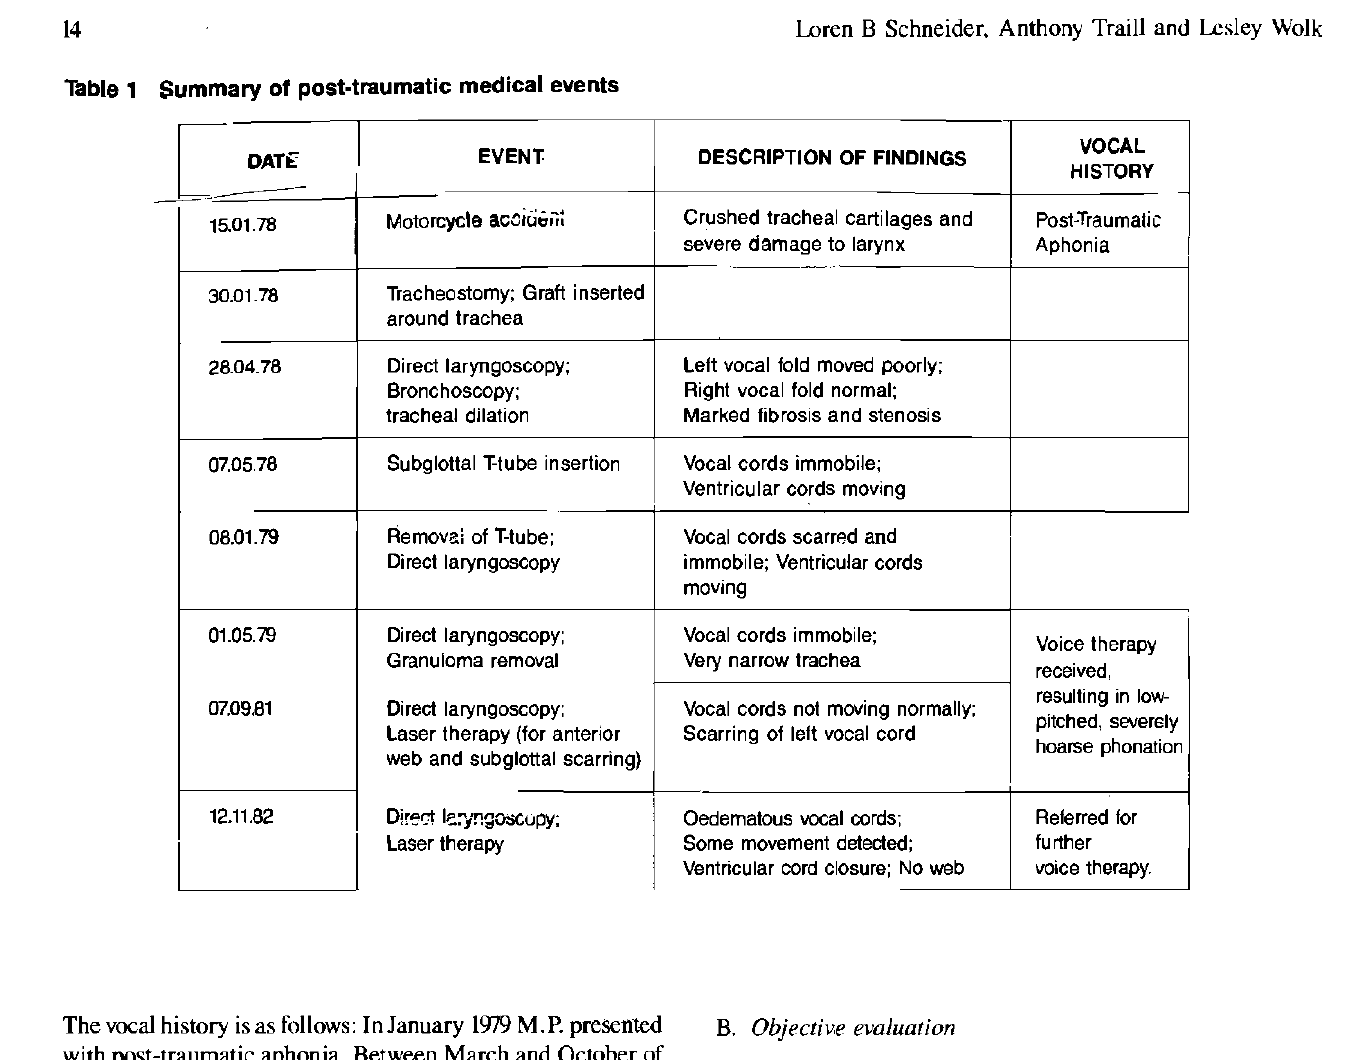
Table 1 Summary of post-traumatic medical